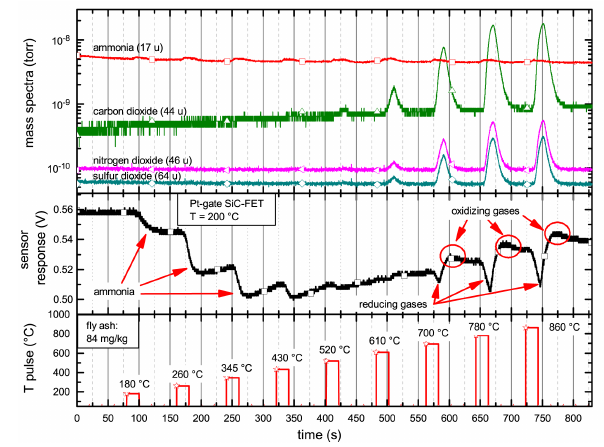
Figure 9. Top: mass spectra; middle: sensor response of a Pt-gate SiC-FET at 200 ◦ C; bottom: heating pulses from 180 to 860 ◦ C of ammonia-contaminated fly ash (84mgkg − 1 ). With PermaPure tube for humidifying the carrier gas (synthetic air).